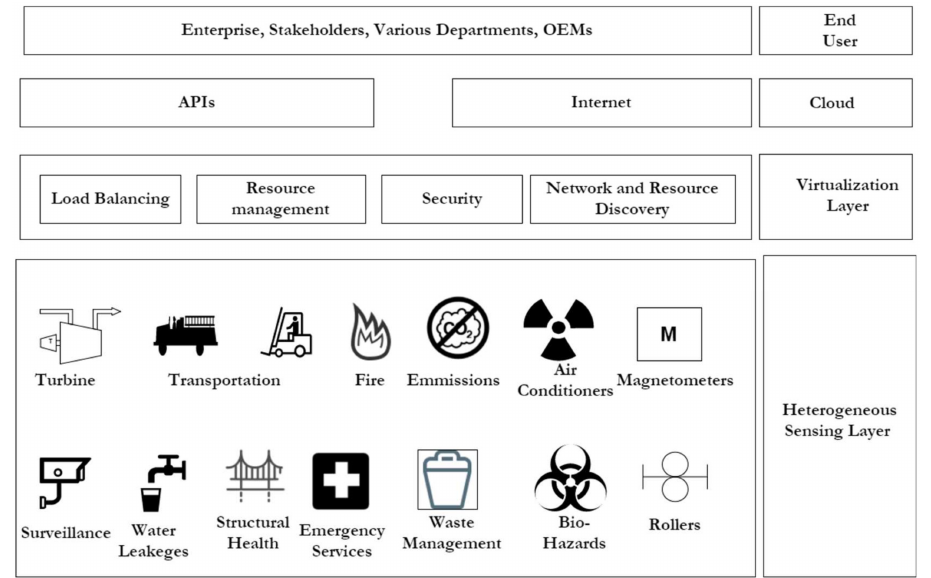
Figure 1. A smart IIoT concept utilizing resource